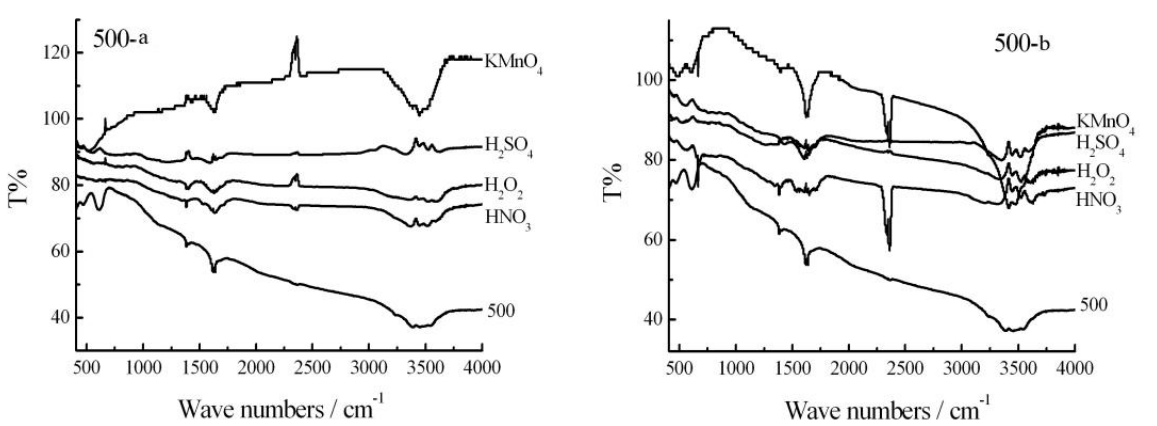
Figure 2: FTIR spectra of biochar obtained at 500 o C before and after modification (a. Dipping, b. Ultrasonic